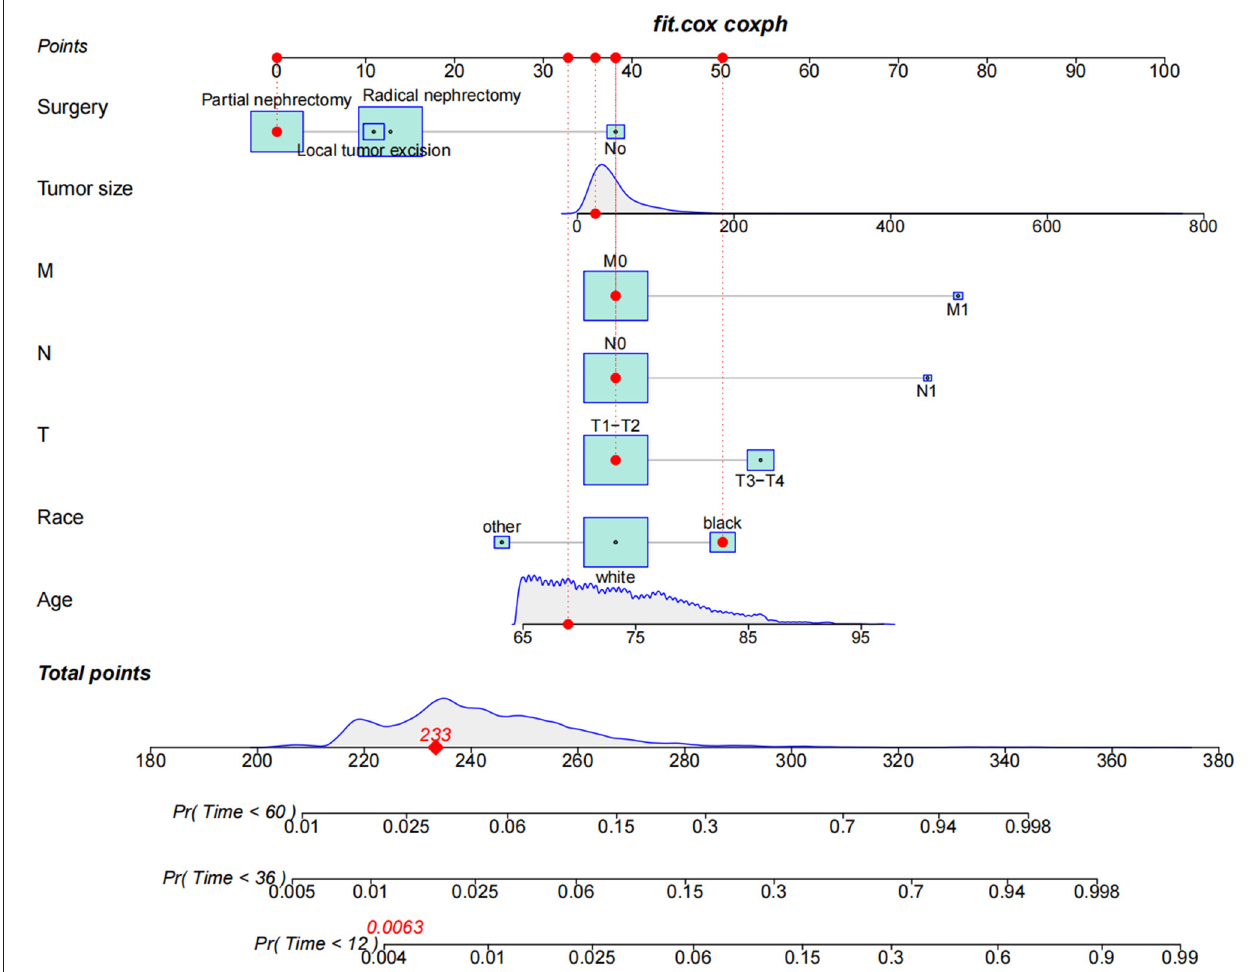
FIGURE 2 | The competitive risk model nomogram of CSS in elderly patients with chRCC at 1-, 3-, and